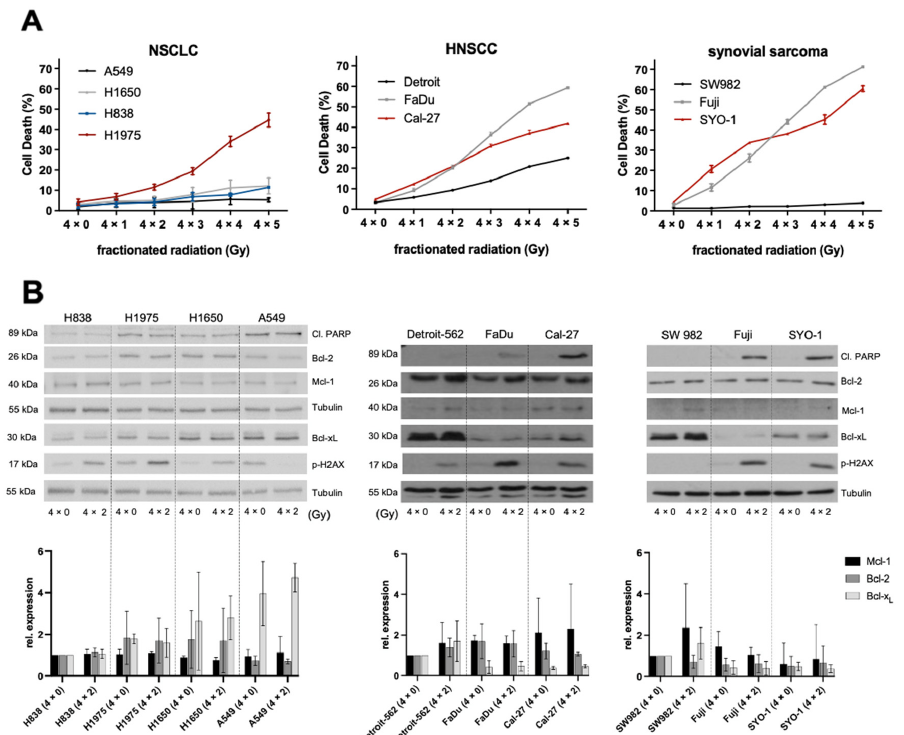
Figure 1. Effects of fractionated radiation on NSCLC, HNSCC and synovial sarcoma cell lines. ( A ) FACS analysis of cell death induction during fractionated radiation. Experiments were performed in triplicate and cell death was measured as mean ± SD. The depicted FACS analyses are representative of at least three independent experiments. ( B ) Representative Western blot analysis of protein development during fractionated radiation and basal protein expression of the Bcl-2-family with Tubulin serving as loading control. Below, a densitometric analysis was performed by norming the expression bands to their respective loading control and using for each entity one cell line as reference. Relative expression was compared between three independent experiments and measured as mean ± SD.